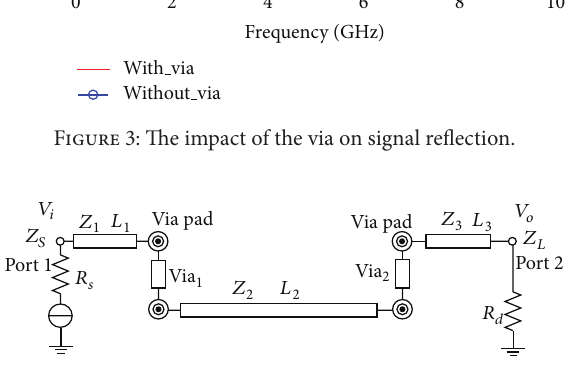
Figure 4: High-speed transmission line